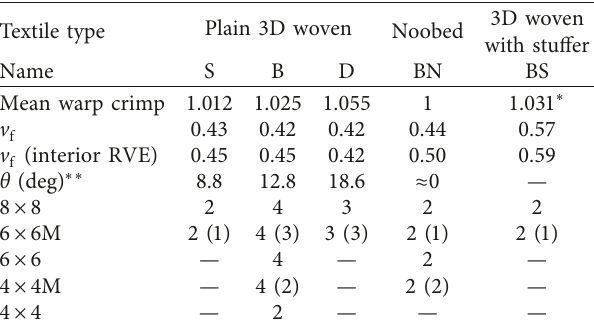
Table 1: Test specimen data, including warp yarn crimps, fibre volume fractions, and mean warp offset